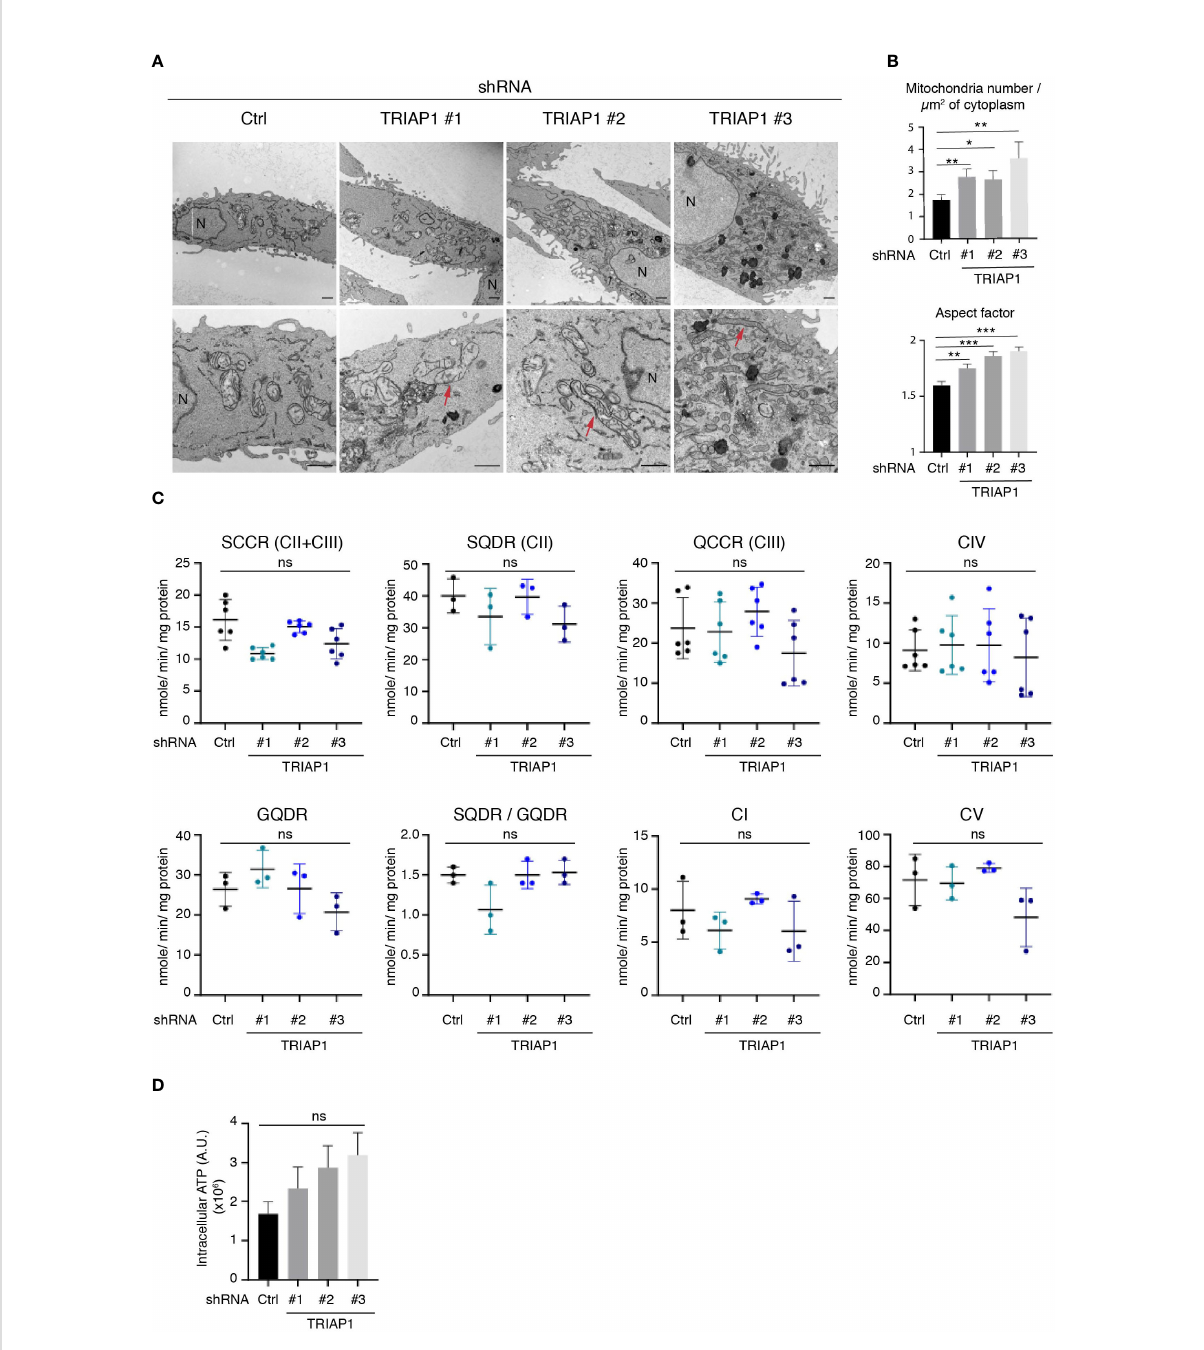
FIGURE 3 Impact of TRIAP1 depletion on mitochondrial structure and function. (A) Mitochondrial structure analysis of HCT116 cells transduced with lentiviral control (Ctrl) or TRIAP1 (TRIAP1 #1, #2, #3) shRNAs. Transmission electron microscopy (TEM) images were analyzed for mitochondrial ultrastructure. N = nucleus. Scale bar = 1 µm. Examples of elongated mitochondria are shown with a red arrow. (B) TEM images were used for the calculation of mitochondria number/µm 2 of cytoplasm surface area and aspect factor (major axis/minor axis; re fl ecting length/width of mitochondria). Statistical analyses were performed using Mann – Whitney non-parametric tests, *p < 0.05, **p < 0.01, ***p < 0.001. (C) Monitoring of the activity of speci fi c segments of the respiratory chain in HCT116 cells transduced with lentiviral control (Ctrl) or TRIAP1 (TRIAP1 #1, #2, #3) shRNAs and cultured in standard medium. Succinate cytochrome c reductase (SCCR; complexes CII and CIII); malonate-sensitive succinate quinone DCPIP reductase (SQDR; complex CII); decylubiquinol cytochrome c reductase (QCCR; complex CIII); glycerol-3-phosphate quinone DCPIP reductase (GQDR; G3PDH); cyanide-sensitive cytochrome c oxydase (complex CIV); rotenone-sensitive NADH quinone reductase (complex CI); oligomycin-sensitive ATPase (complex CV). (D) Measurement of ATP levels. Average ATP levels were quanti fi ed in HCT116 cells transduced with lentiviral control (Ctrl) or TRIAP1 (TRIAP1 #1, #2, #3) shRNAs and cultured in standard medium. For statistical comparison, Kruskal – Wallis tests were performed. *p < 0.05 is considered signi fi cant (ns, non-signi fi